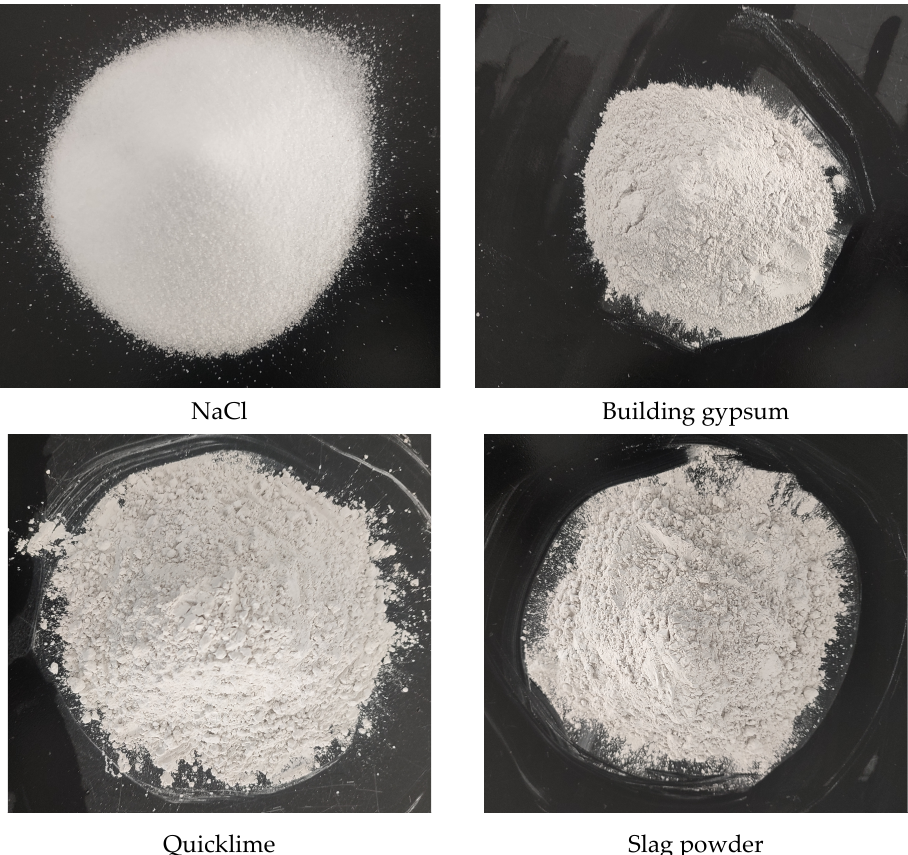
Figure 2. Materials used in geopolymer. The flowchart of the study is shown in Figure 3.